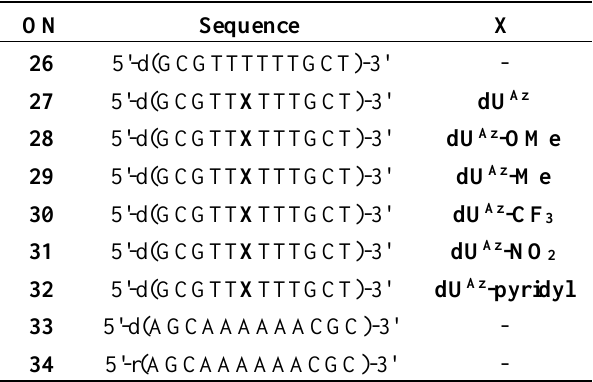
Table 2. The oligonucleotides used in this study.